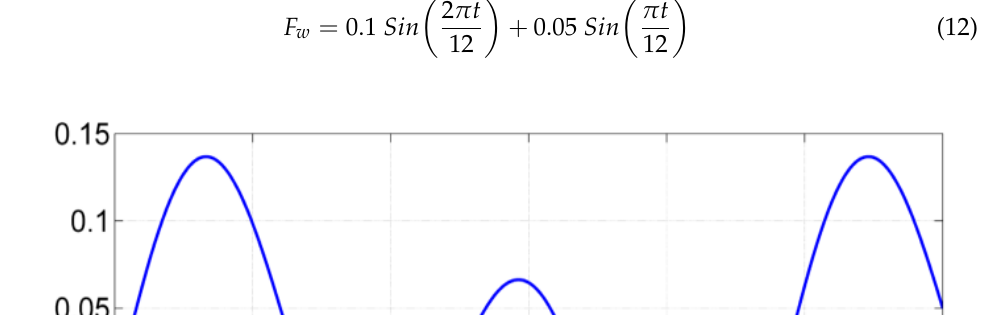
Figure 8. Adaptive controller parameters: ( a ) Proportional and ( b ) Integral Gains for the two areas.